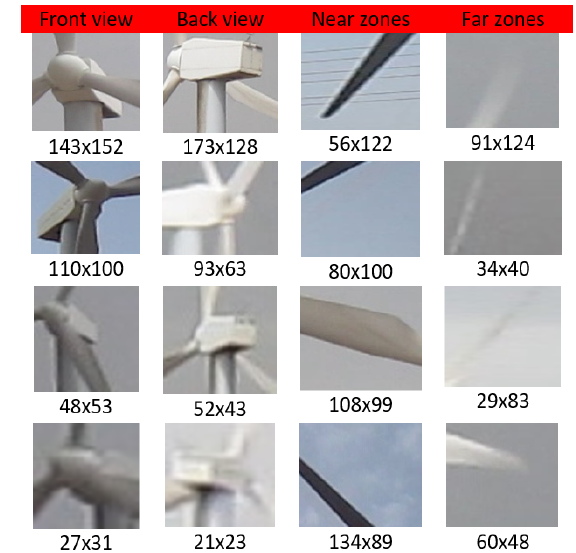
Figure 5. Some selected samples of hubs and blades images at original sizes from our dataset: hubs (front view and back view), blades ( near zones and far